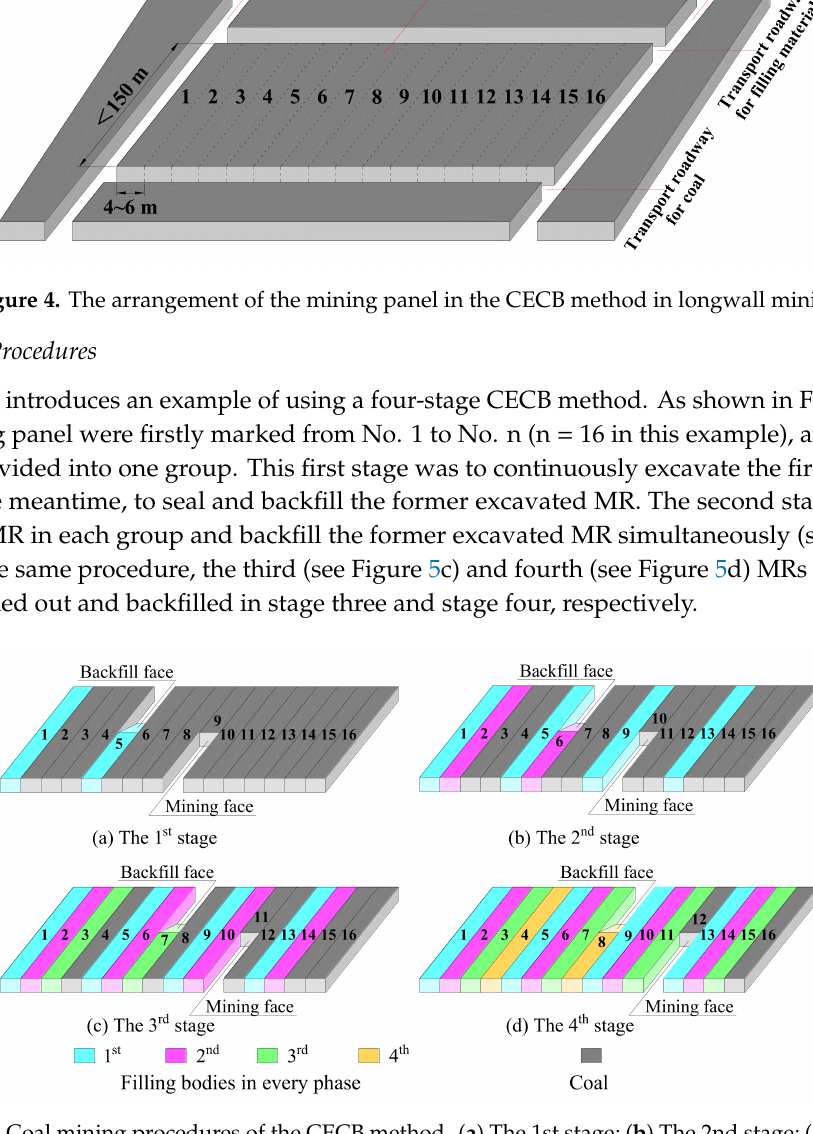
Figure 5. Coal mining procedures of the CECB method. ( a ) The 1st stage; ( b ) The 2nd stage; ( c ) The 3rd stage; ( d ) The 4th